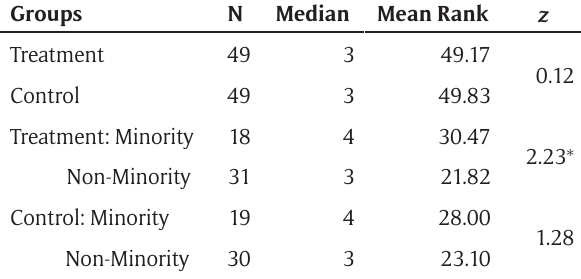
Table 5: Comparisons of groups on perceived efficacy in doing other citizen science projects. *p ≤